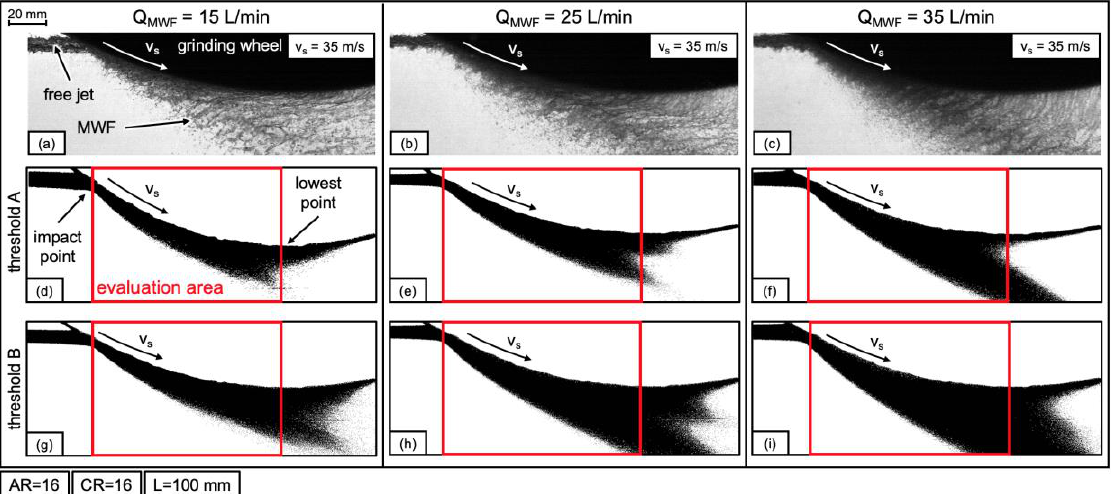
Figure 15. Evaluation of the shadowgraphy records with two different thresholds, ( a – c ) high-speed- records, ( d – f ) shadowgraphy records for threshold A, ( g – i ) shadowgraphy records for threshold